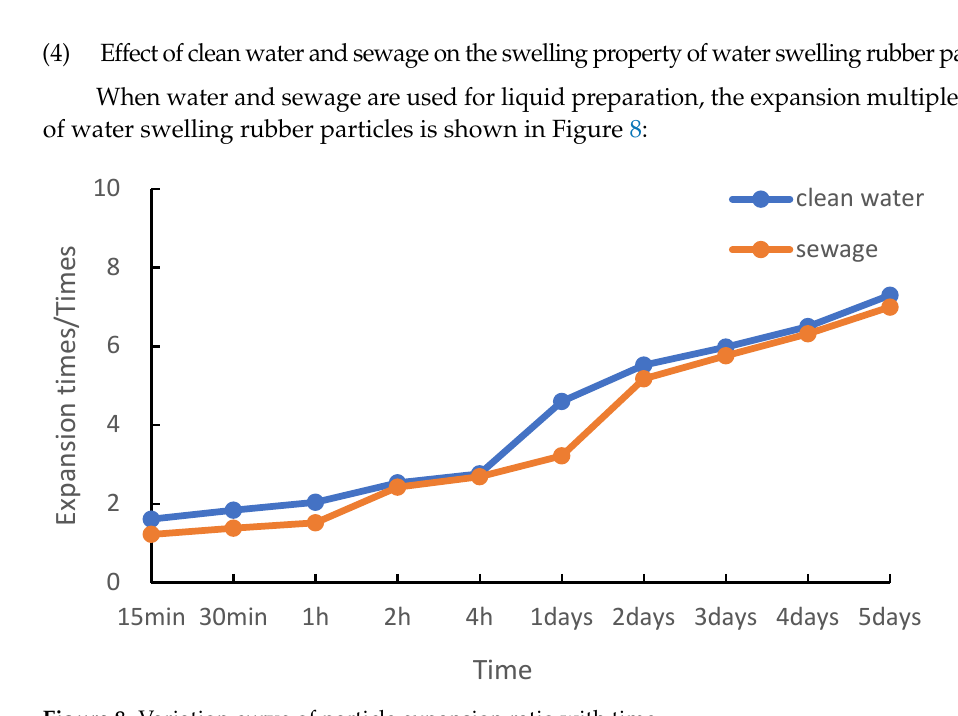
Figure 8. Variation curve of particle expansion ratio with time. It can be seen from Figure 8 that the water swelling rubber particles will not expand rapidly within 30 min to 4 h in clean water polymer solution and sewage polymer solution but will expand slowly with time. The expansion ratio of particles in clean water at the initial stage is slightly higher than that in sewage, but the difference between the expansion ratios of the two will gradually narrow over time, and eventually become consistent. To sum up, the water swelling rubber particles have the characteristics of slow ex- pansion in both clean water and sewage, indicating that the particles will not expand prematurely during the injection process, the injection performance is good, and the expan- sion times in sewage and clean water are almost the same, which can be directly configured into sewage polymer solution for injection. Evaluation results of compressive strength of water swelling rubber particles The pore strength of water swelling rubber particles is shown in Table 7: Table 7. Particle Via Pressure